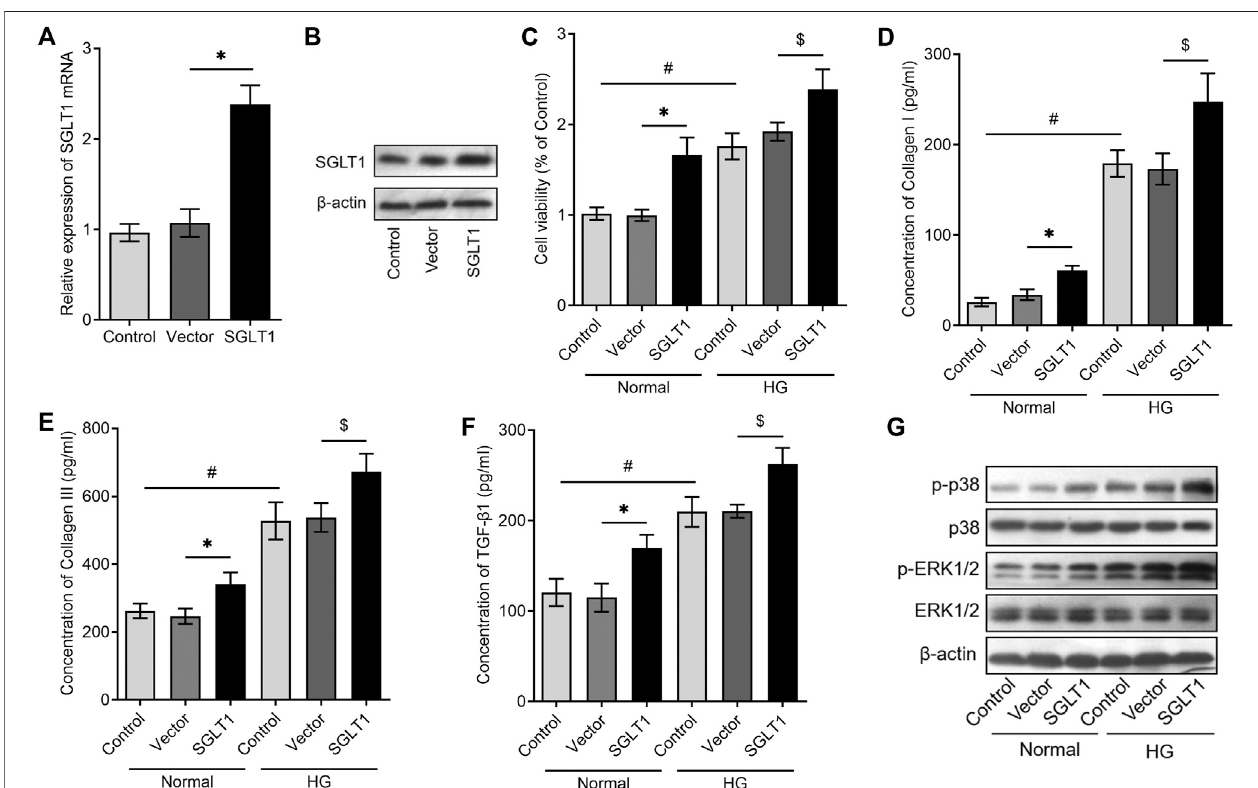
FIGURE 4 | SGLT1 overexpression promotes collagen release via the p38 and ERK1/2 signaling pathway in CFs. CFs were transfected with an SGLT1 plasmid or vector, and SGLT1 expression levels were detected using RT-qPCR (A) or western blotting analysis (B) . (C) After overexpression of SGLT1 in CFs, CCK-8 assay was usedtodetecttheproliferationofCFsundernormalorhigh-glucosecondition( n (cid:2) 6). (D – F) AfteroverexpressingSGLT1inCFs,thecollagen-synthesis – relatedmarkers, includingTGF- β 1,collagenI,andcollagenIII,inthecellsupernatantweremeasuredusingELISA( n (cid:2) 6). (G) AfteroverexpressingSGLT1inCFs,theproteinlevelsof phosphorylated p38 and p-ERK1/2 were analyzed using western blotting in CFs both under normal or high-glucose condition ( n (cid:2) 3).